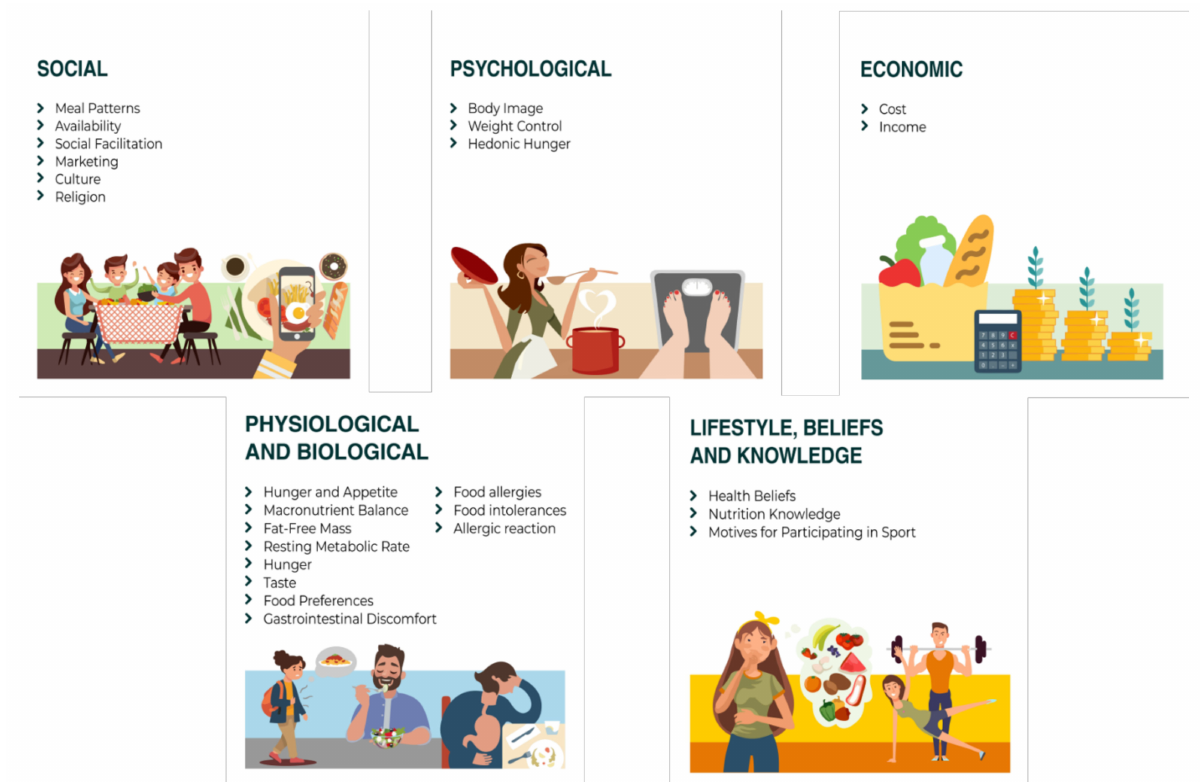
Figure 1. Factors influencing dietary choices of